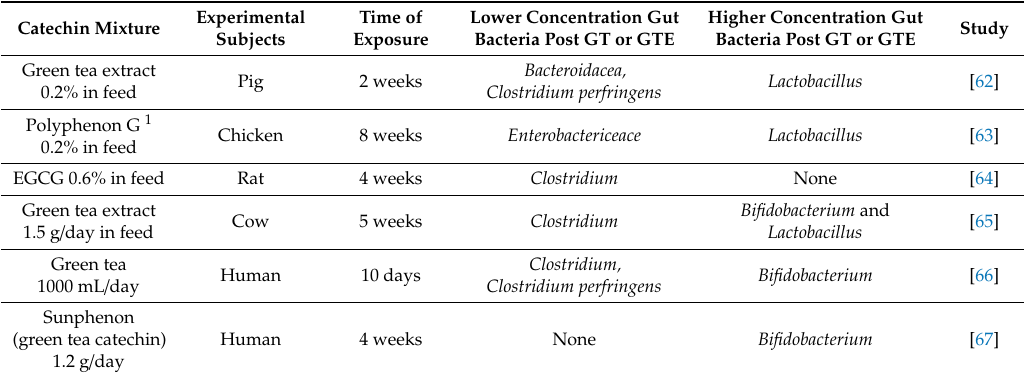
Table 3. E ff ects on Gut